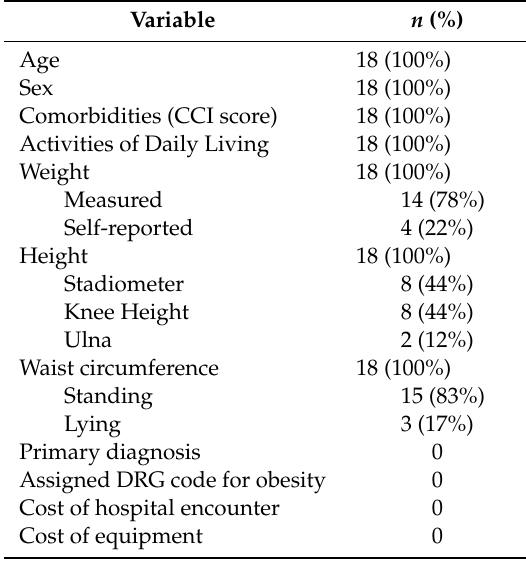
Table 3. Summary of available data for participants with completed observations ( n = 18) at completion of study